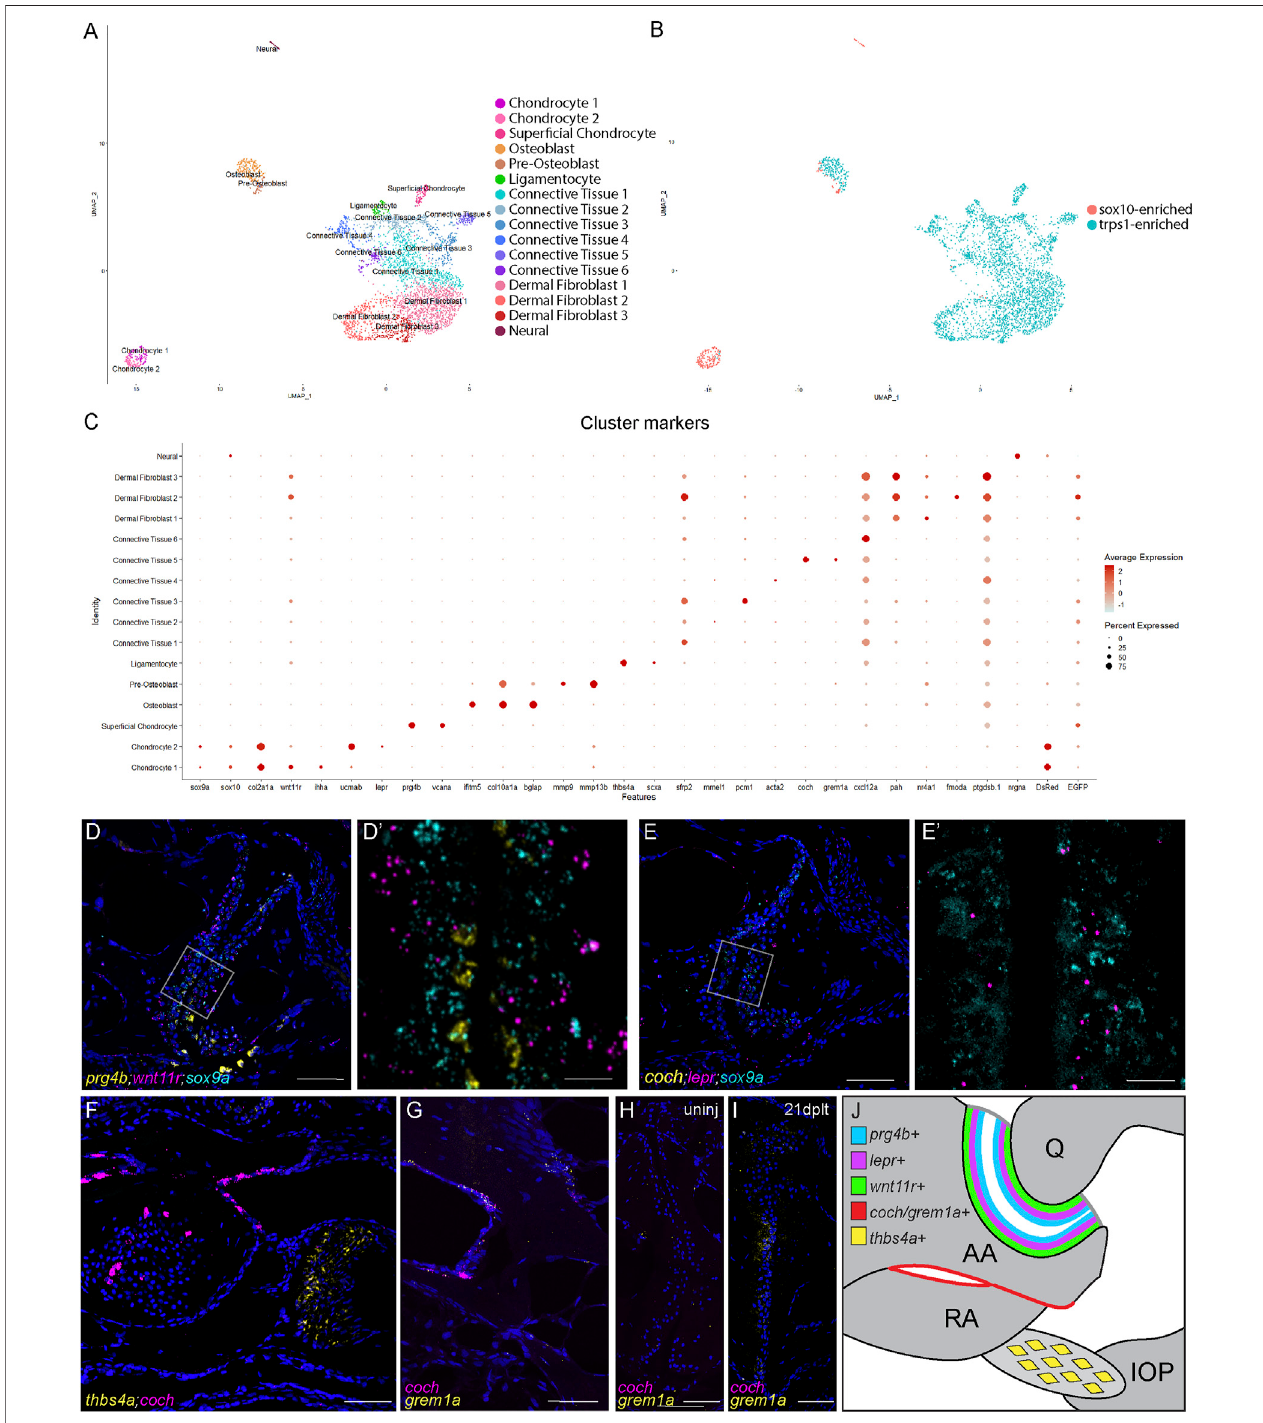
FIGURE 4 | Single-cell transcriptome of adult zebra fi sh jaw joint. (A, B) UMAP visualization of scRNAseq analysis of FACS-sorted 3-month-old jaw joints. The colors were based on clustering (A) or library of origin (B) . (C) Dot plot showing the marker gene expression for each cell cluster as well as DsRed and GFP transcripts. (D – G) RNAscope in situ hybridization for markers for chondrocyte clusters (D,E) , for CT5 ( coch ) and ligament ( thbs4a ) (F) , and for CT5 ( coch and grem1a ) (G) . Nuclei stained with DAPI in blue. The magni fi ed regions of the boxed regions (D 9 ,E 9 ) highlight different zones of joint chondrocytes and are shown without the DAPI channel.Thesectionin (F) isabovethejawjointsectionsof (D,E) . (H,I) RNAscope insitu hybridizationfor grem1a and coch atthearticularsurfaceofuninjured (H) and21 dplt (I) jaw joints. Nuclei stained with DAPI in blue. (J) Model of chondrocyte zones (blue, purple, and green), joint-adjacent periosteum (red), and interopercular – mandibular ligament (yellow) with marker genes in the adult jaw joint. Scale bars (cid:1) 50 μ m (D – H) and 10 μ m (D 9 ,E 9 ) .